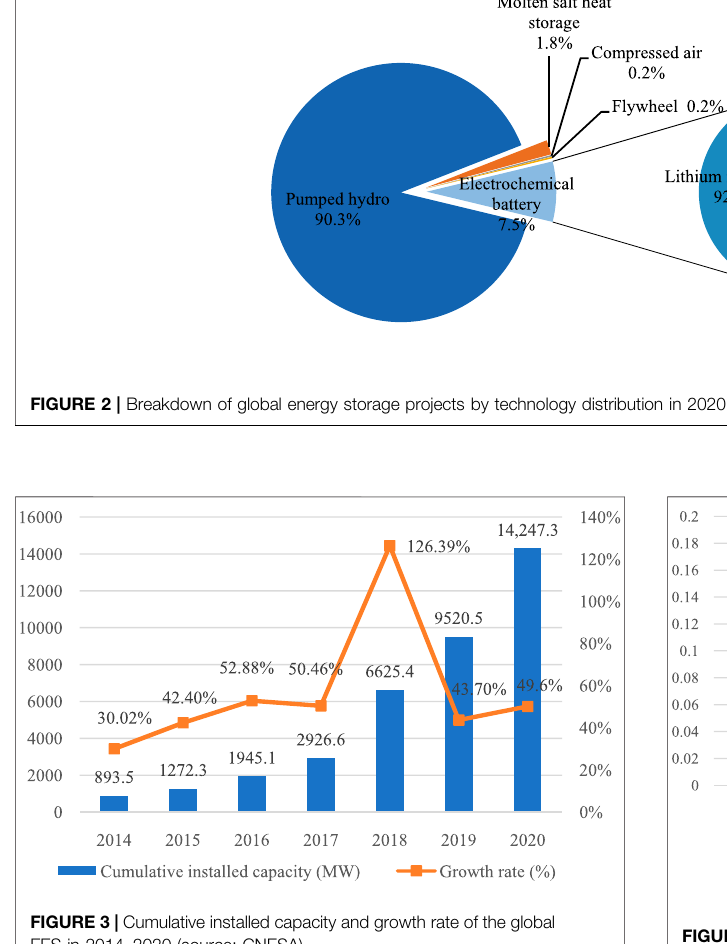
Frontiers in Energy Research |